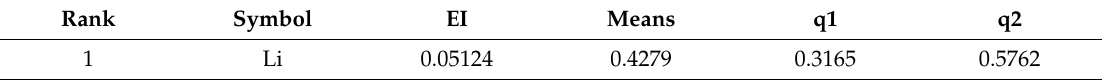
Figure 6. Prediction of the 2nd GPR model selected by the EI ranking. Table 7. Prediction by the second regression model for further screening.